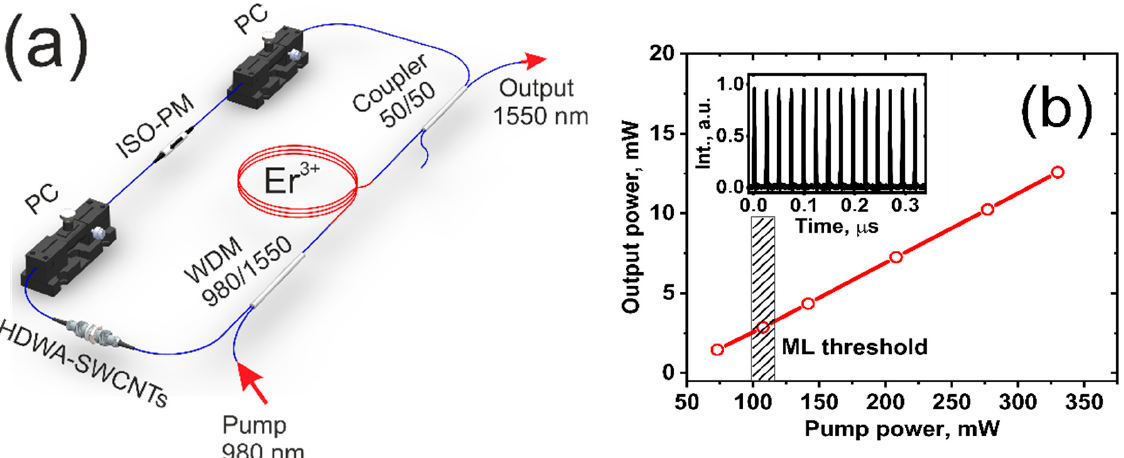
Figure 5. ( a ) Experimental setup of the hybrid ML fiber laser. ( b ) Output power vs. pump power and output pulse trace.